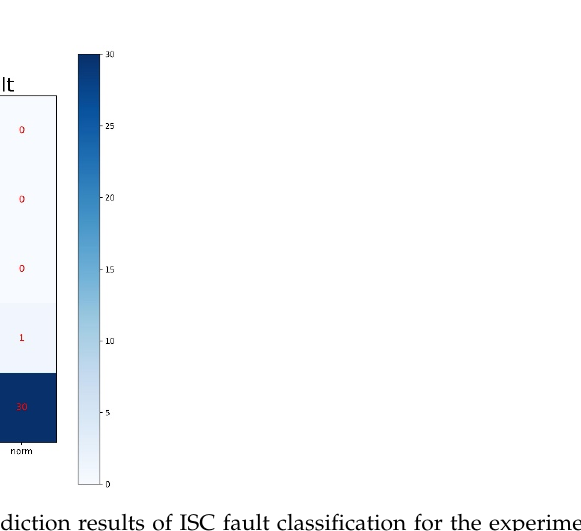
( b ) Figure 10. The laboratory battery pack voltage characteristic curve with an ISC resistance of 10 Ω : ( a ) Voltage curve of ISC; and ( b ) Normalized voltage curve. The processed laboratory voltage curve data were inputted into the trained ResNet ‐ CNN model, and the predicted results were obtained as shown in Figure 11. Analyzing the prediction results, it can be seen from Figure 11 that for the laboratory data, all three class I ISC level faults were predicted, while the other two class II and III ISC level faults,